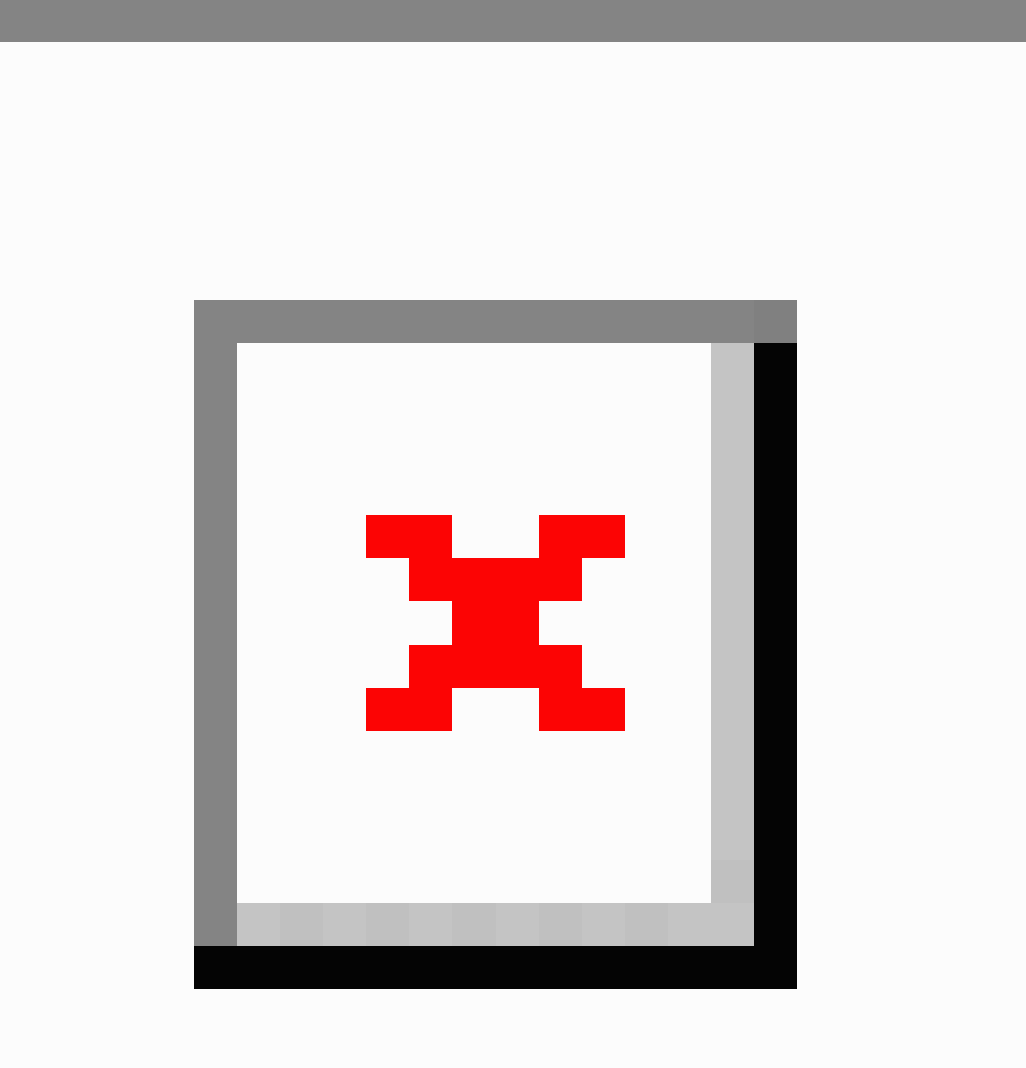
Figure 2. The mobile Augmented Reality blended learning environment with the module “Forensic Medicine”: AR simulation of a gunshot wound and connected multimedia